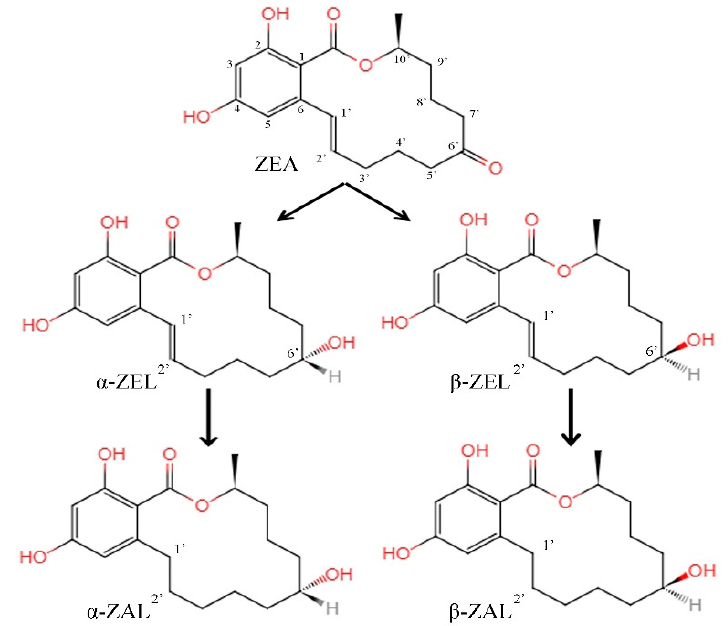
Figure 1. The formation pattern of secondary metabolites of zearalenone. ZEA: Zearalenone. α - / β -ZEL: α - / β -zearalenol. α - / β -ZEL: α - / β